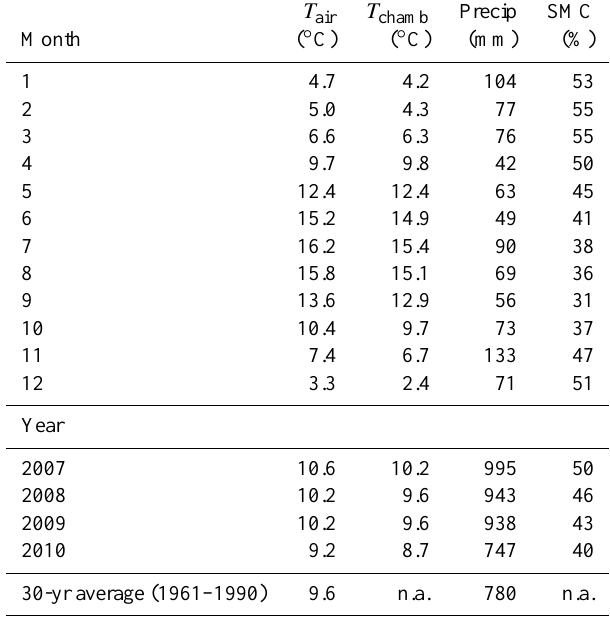
Table 1. Monthly and annual average air temperature ( T air ) from 2007 to 2010 measured at 1m at the eddy covariance measurement site in the Straits Enclosure, Alice Holt forest, and inside the soil CO 2 flux chambers ( T chamb ) together with precipitation sums (Pre- cip), and soil volumetric moisture content (SMC; v / v ) at 6cm depth in the mineral layer. The long-term averages are provided for com- parison; n.a. indicates data not